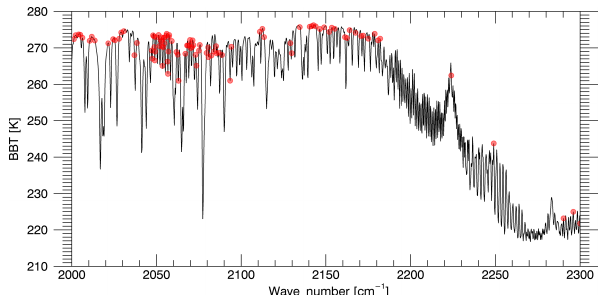
Figure 8. The top 100 spectral points (red circles) ranked in Fig. 7 from the channel selection are shown for reference as compared to all 1201 channels from the observed spectrum (black line) for a mid-latitude atmospheric